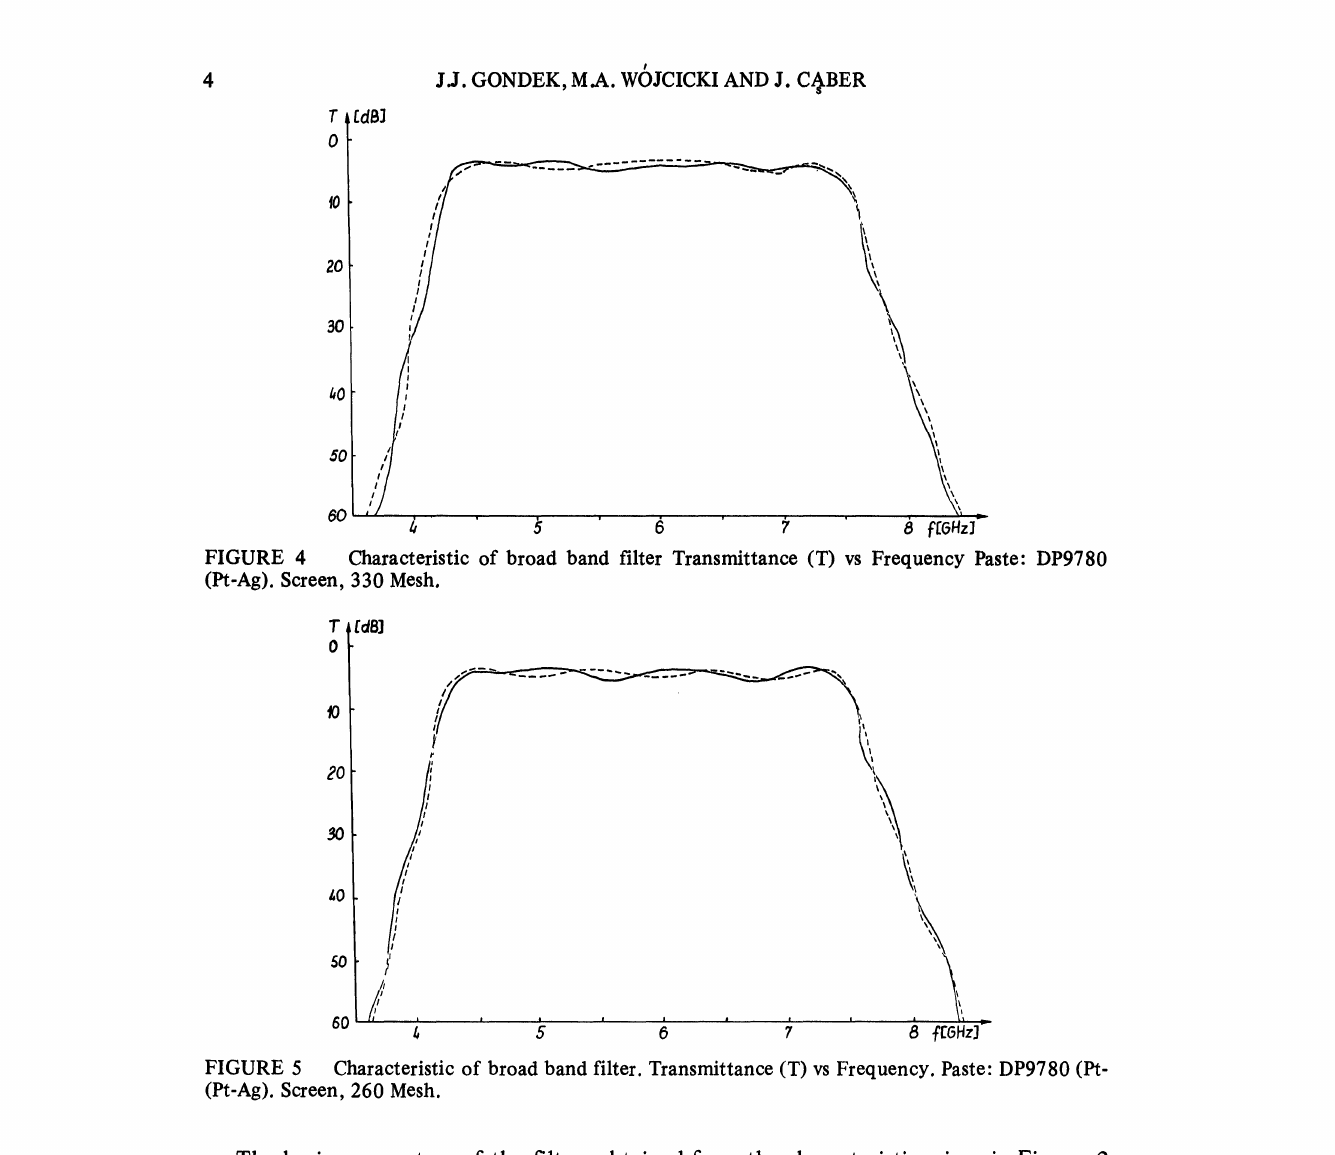
FIGURE 5 Characteristic of broad band filter. Transmittance (T) vs Frequency. Paste: DP9780 (Pt- (Pt-Ag). Screen, 260